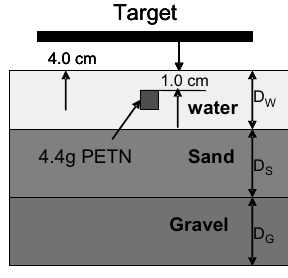
Fig. 2. Experimental